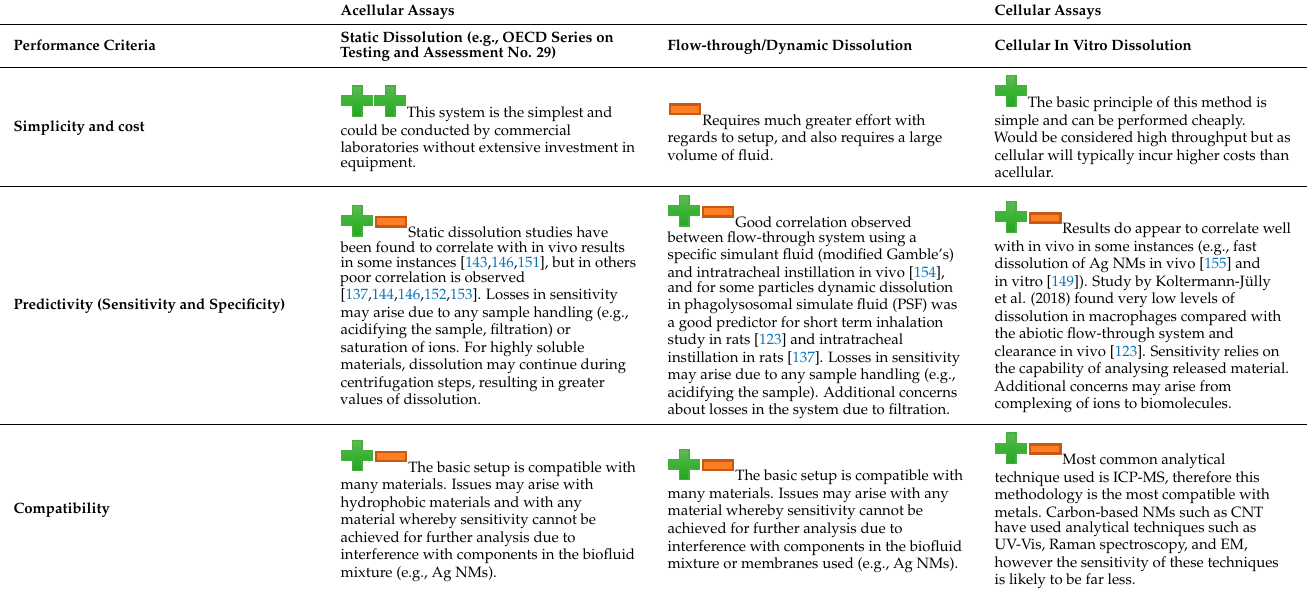
Table 2. Evaluation of suitability of dissolution assays for SbD hazard testing. Table 1. Evaluation of suitability of cytotoxicity assays for SbD hazard testing. Table 1. Evaluation of suitability of cytotoxicity assays for SbD hazard testing. Table 1. Evaluation of suitability of cytotoxicity assays for SbD hazard testing. Table 1. Evaluation of suitability of cytotoxicity assays for SbD hazard Table 1. Evaluation of suitability of cytotoxicity assays for SbD hazard testing. Table 1. Evaluation of suitability of cytotoxicity assays for SbD hazard testing.